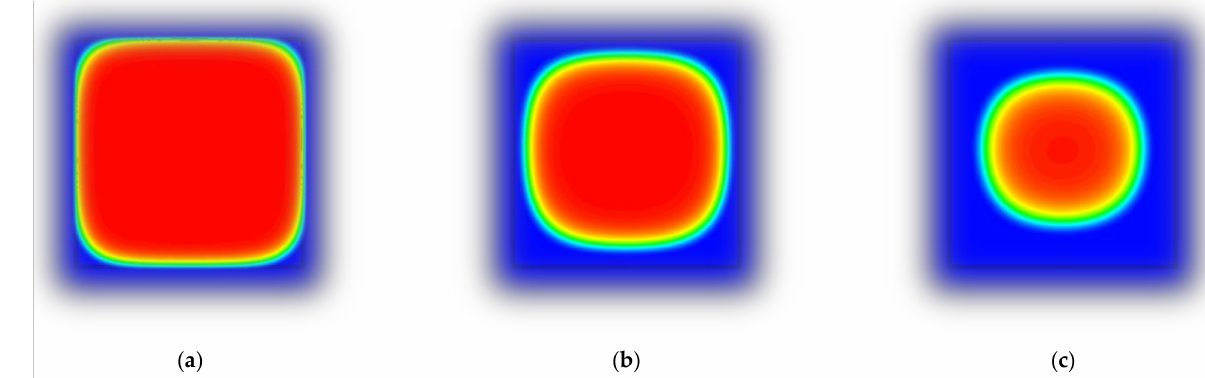
Figure 8. Concentration of initial moisture at ( a ) t = 5 s, ( b ) 10 s and ( c ) 15 s. Particle Devolatilization